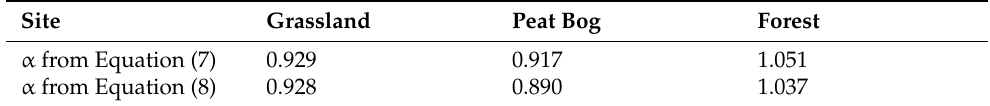
Table 4. α derived from Equations (7) and